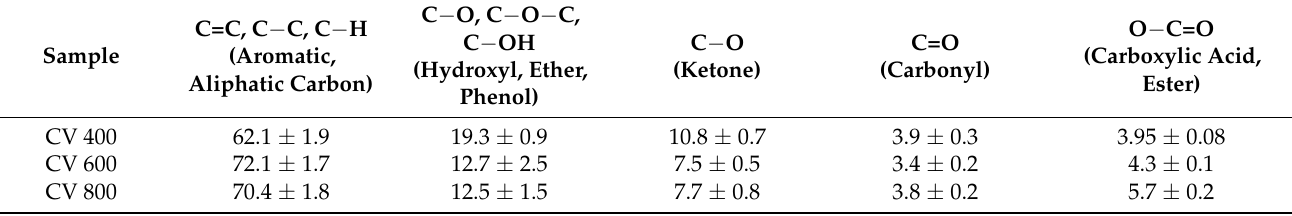
Table 1. Tables should average percentage of functional states in C1s XPS